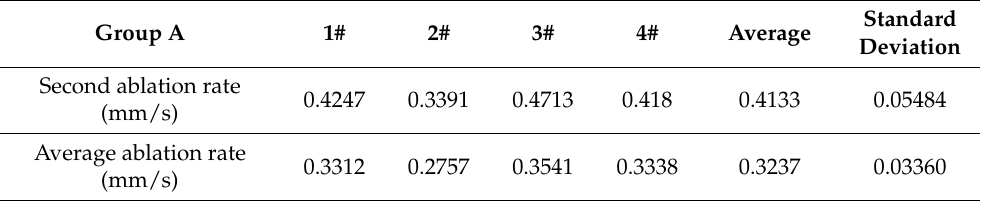
Table 4. Ablation rate of Group A in second ablation experiment and whole process (gas phase velocity was 30 m/s).